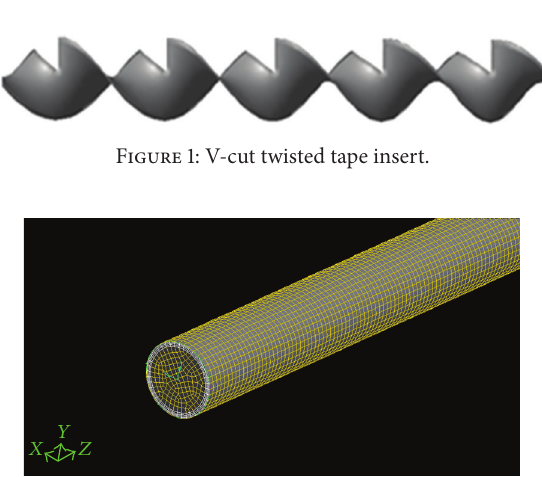
Figure 2: Grid for the plain